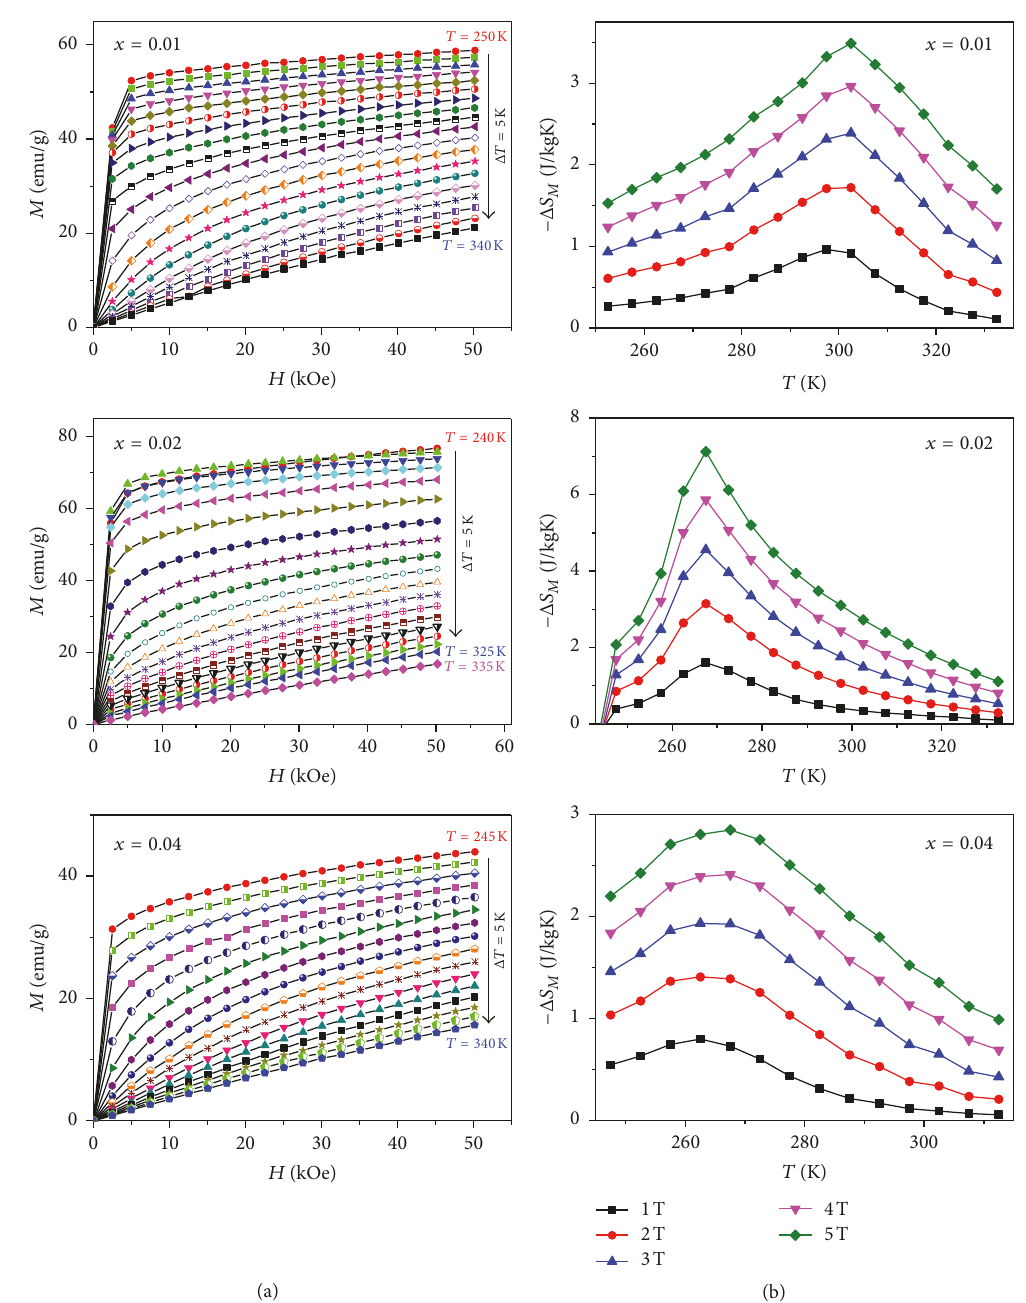
Figure 6: Isothermal magnetization 𝑀(𝐻) curves (a) and magnetic entropy changes, −Δ𝑆 𝑀 (𝑇) (b), with a magnetic field change Δ𝐻 = 5T for MnCo 1−𝑥 Zr 𝑥